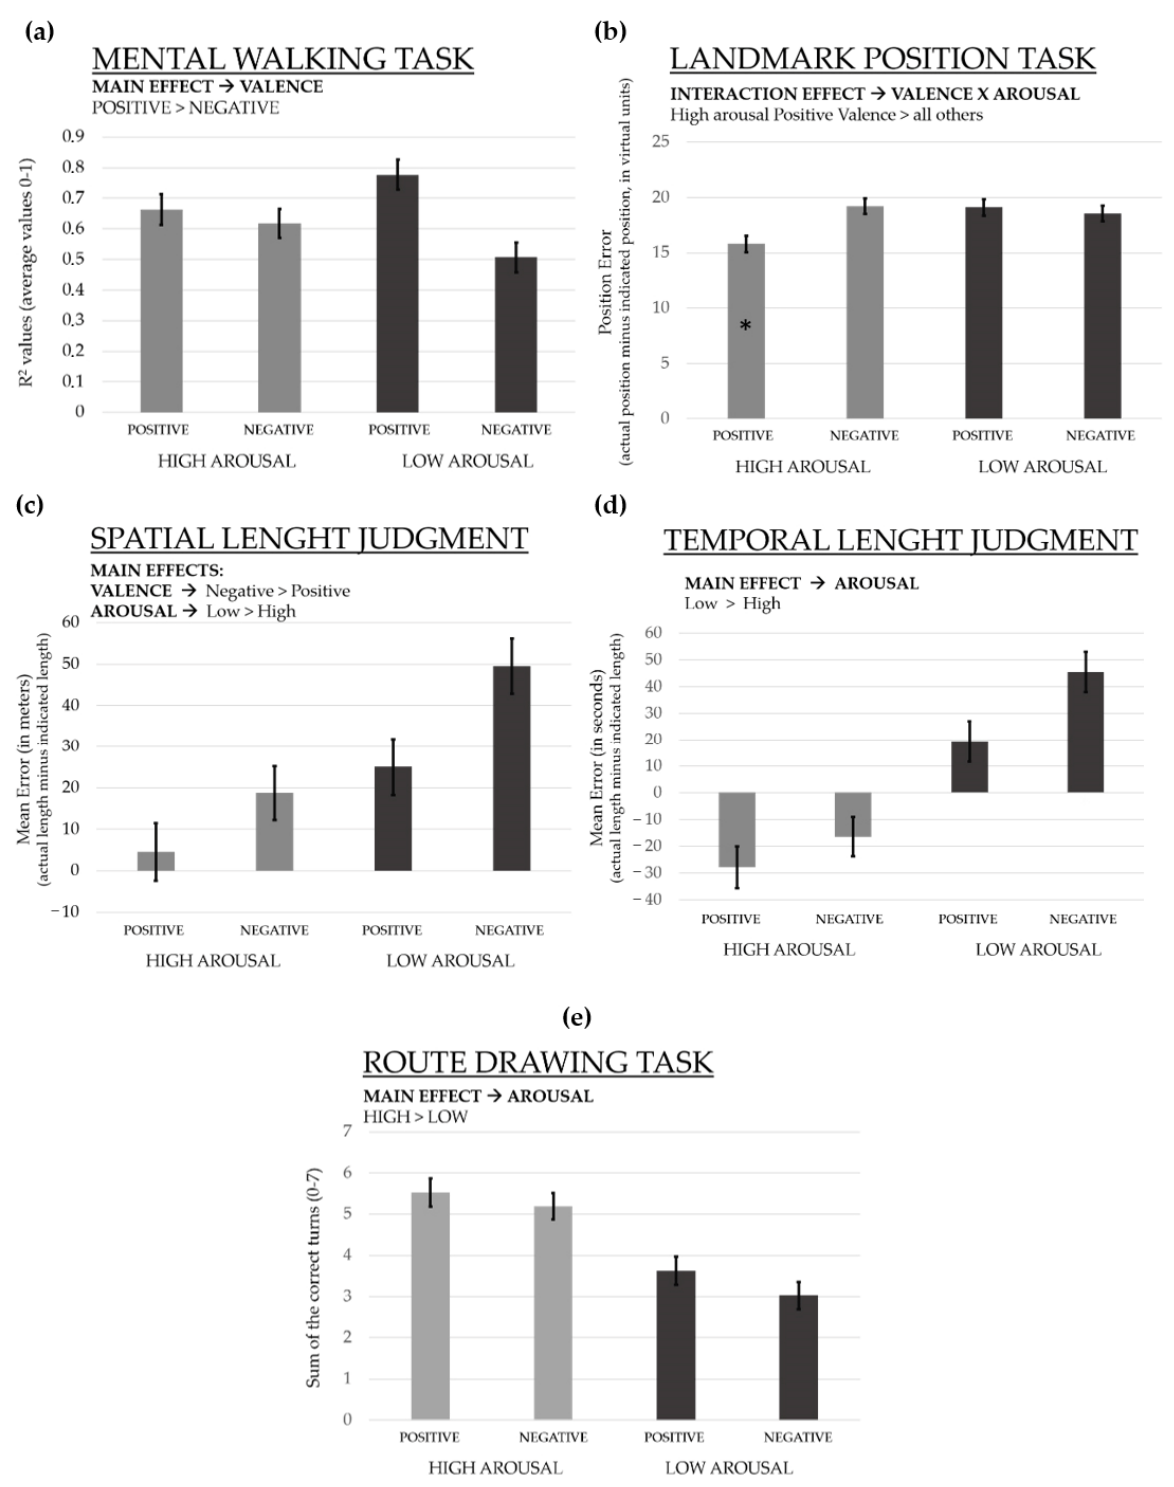
Figure 2. The graphs represent participants’ performance in the five tasks ( a – e ) as a function of the experimental condition (high or low arousal and positive or negative valence). The vertical black thin bars represent standard error. * p <